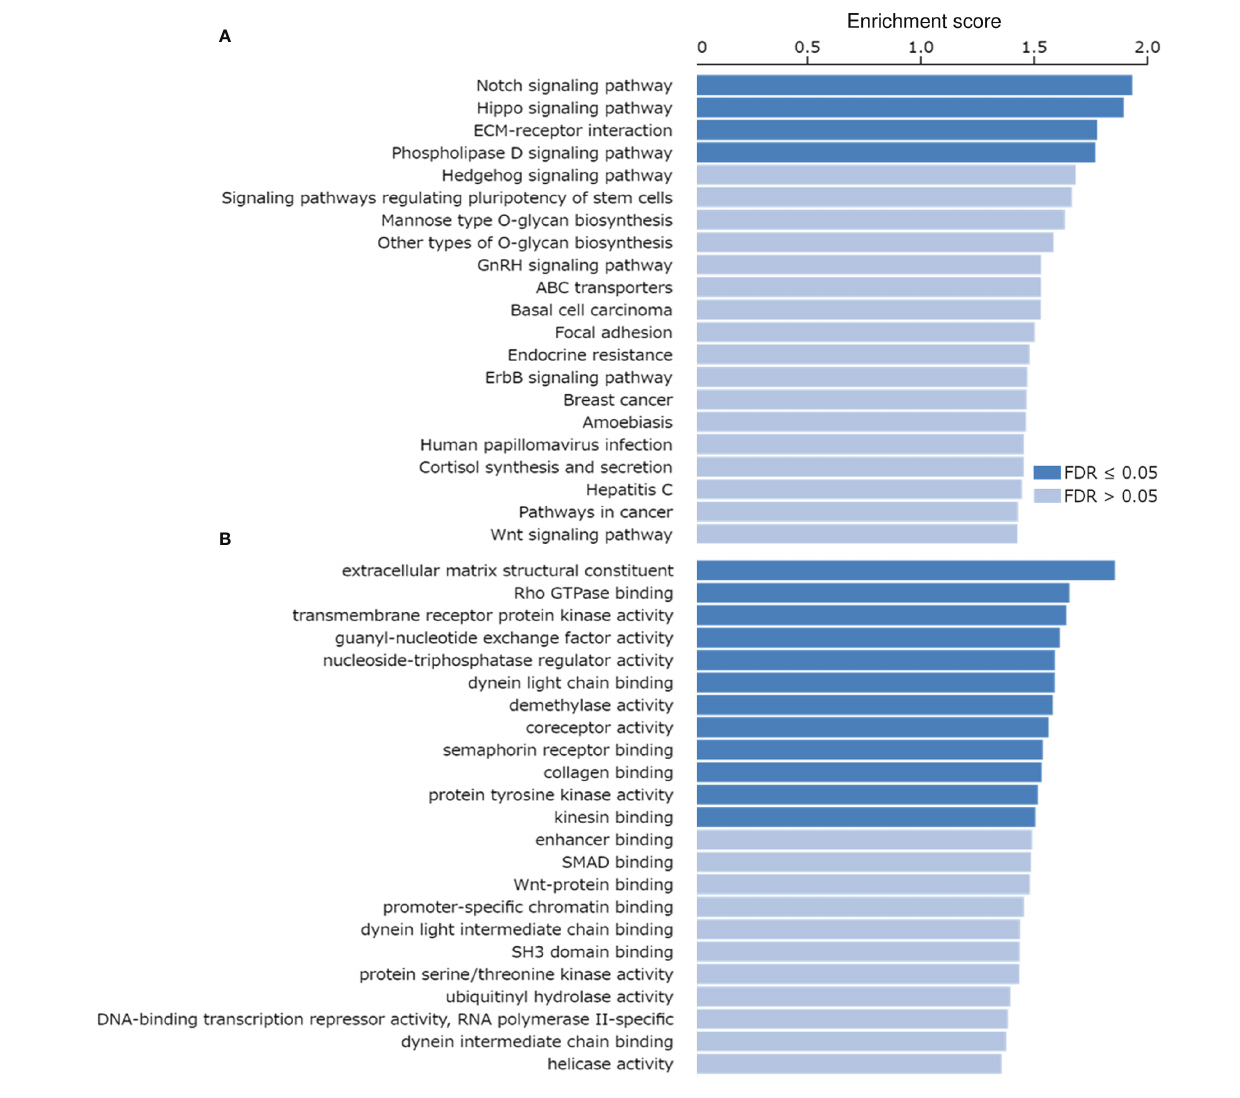
FIGURE 2 | KEGG Pathways Analysis and GO Functional Annotation of the Co-expressed Genes of MRP-7 in EC Tissues. (A, B) KEGG pathway enrichment analysis (A) and GO functional annotation (cellular function) (B) of the co-expressed genes of MRP-7 in EC samples were investigated using the LinkedOmics